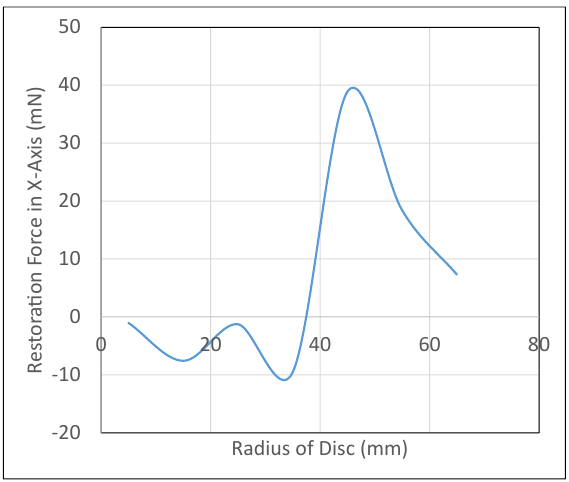
Figure 14. The need for a micromanipulator semi-levitation